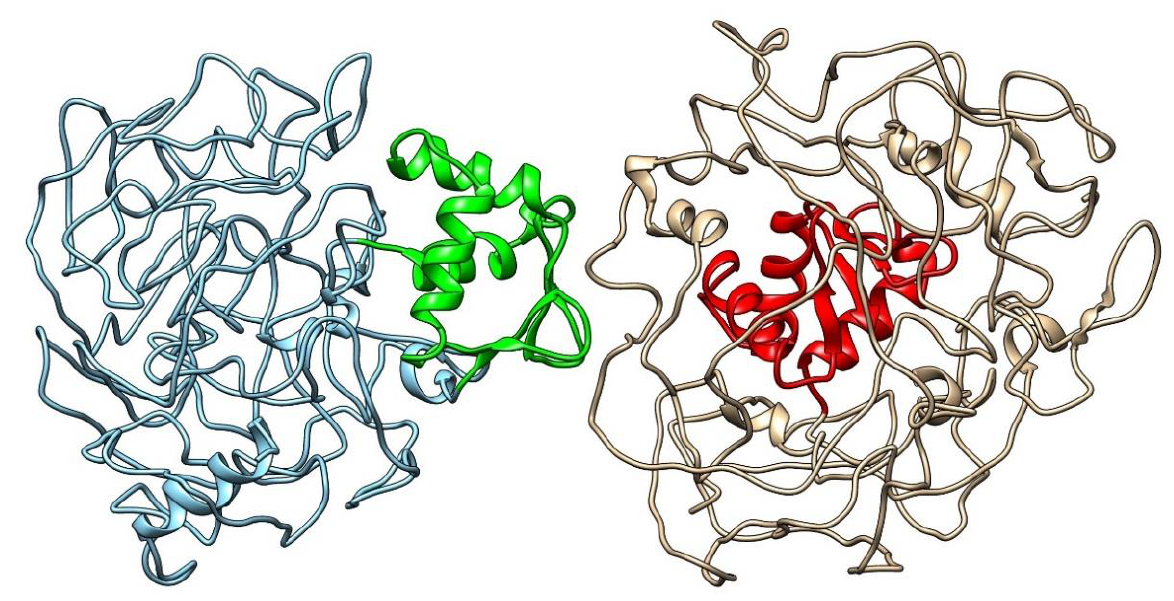
Cancers 2021 , 13 , x Figure 2. Two ERF wild type and variant structures (wildtype: blue; variant: tan) were compared side-by-side in UCSF Chimera. The DNA binding regions of the proteins are highlighted (wildtype: green; variant: red).